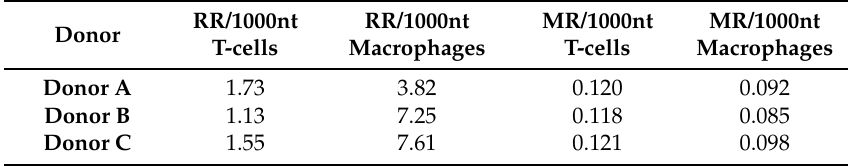
Table 3. Results from experimental infections split by donor.